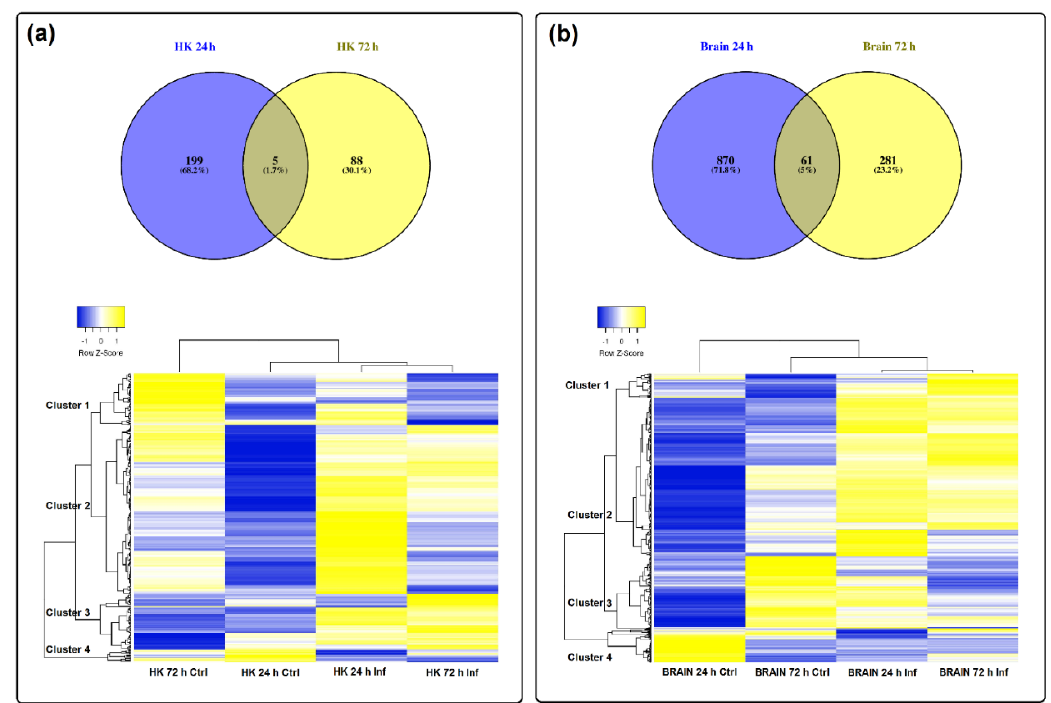
Figure 4. Modulation of lncRNAs in ( a ) head kidney and ( b ) brain after nodavirus challenge. Venn diagrams represent the number of shared and unshared lncRNAs significantly modulated at each sampling point (FC > 2, FDR < 0.05). Heat maps of the lncRNAs significantly affected by the infection in each tissue and hierarchical clustering of the different samples constructed with the TPM values.